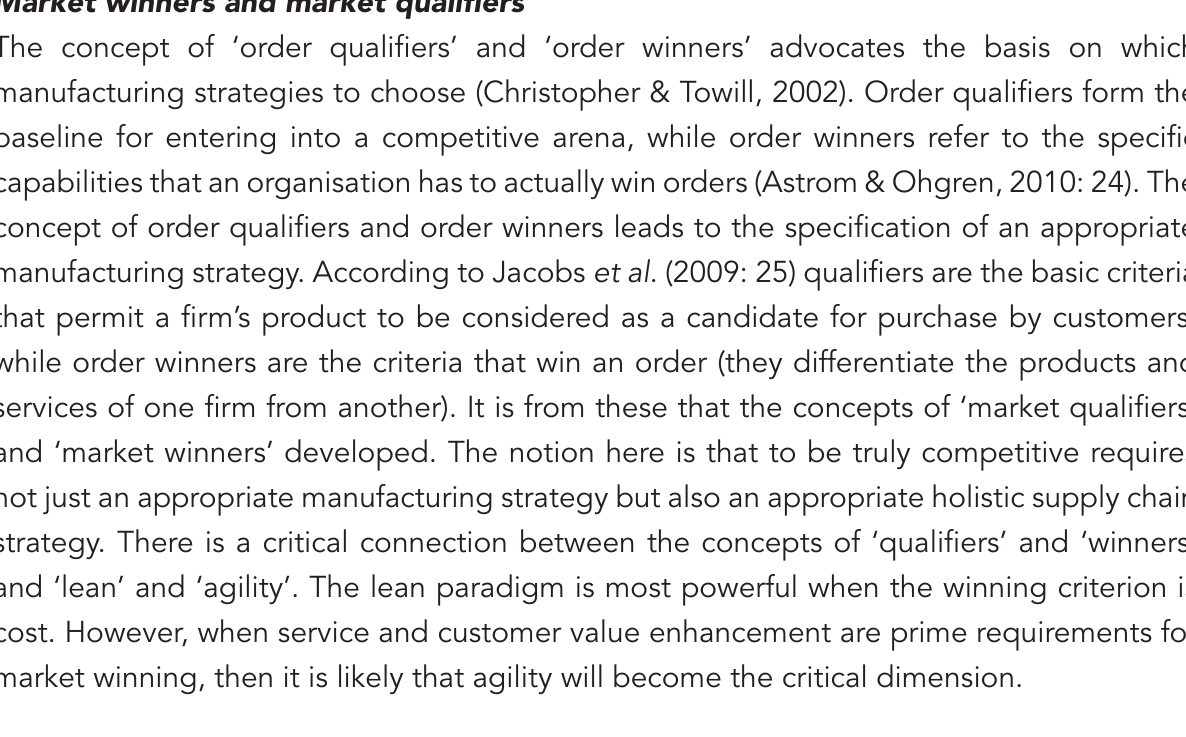
Figure 2: Product-process matrix: framework describing layout strategies Source: Jacobs et al (2009:207); Stavrulaki and Davis